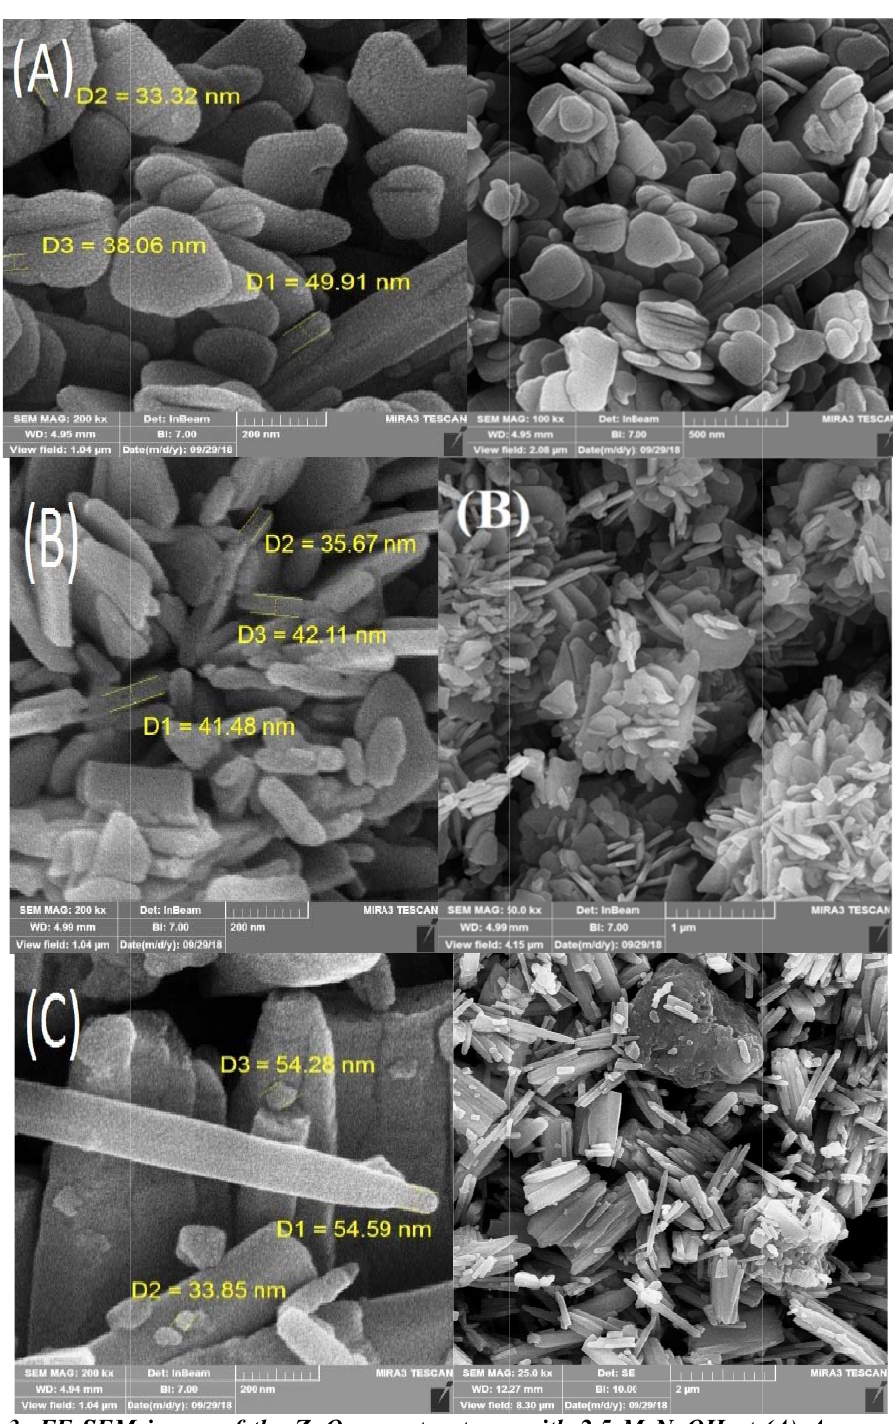
nostructures s with 2.5